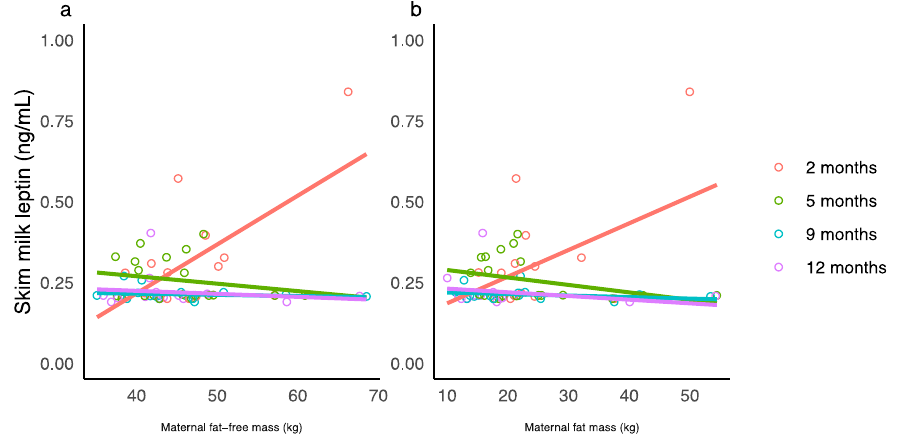
Figure 1. Significant interaction between maternal body composition and the month after birth for skim milk leptin concentration. ( a ) Maternal fat-free mass and ( b ) maternal fat mass measured with bioelectrical impedance spectroscopy. Lines represent linear regression and grouped by the month of lactation.